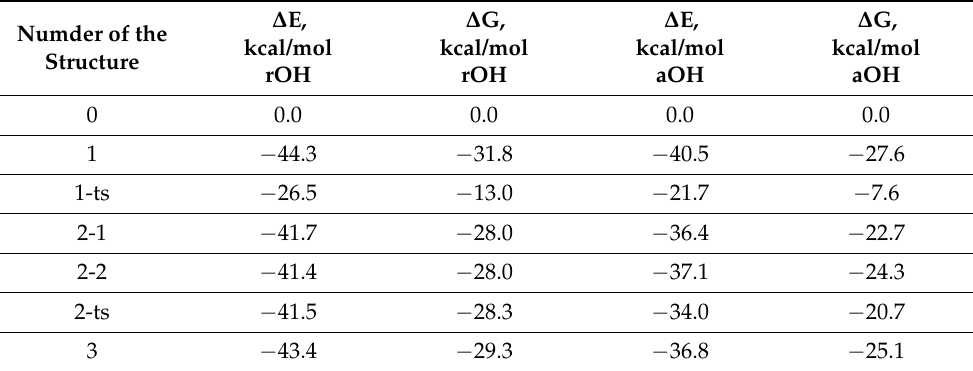
Table 4. The results of quantum-chemical calculations of the PES for reaction 22 with rOH and aOH in aqua media. ∆ G, ∆ E, ∆ G, ∆ E, Numder of the kcal/mol kcal/mol kcal/mol kcal/mol Structure aOH aOH rOH rOH 0 0.0 0.0 0.0 0.0 1 − 44.3 − 31.8 − 40.5 − 27.6 1-ts − 26.5 − 13.0 − 21.7 − 7.6 2-1 − 41.7 − 28.0 − 36.4 − 22.7 2-2 − 41.4 − 28.0 − 37.1 − 24.3 2-ts − 41.5 − 28.3 − 34.0 − 20.7 3 − 43.4 − 29.3 − 36.8 −